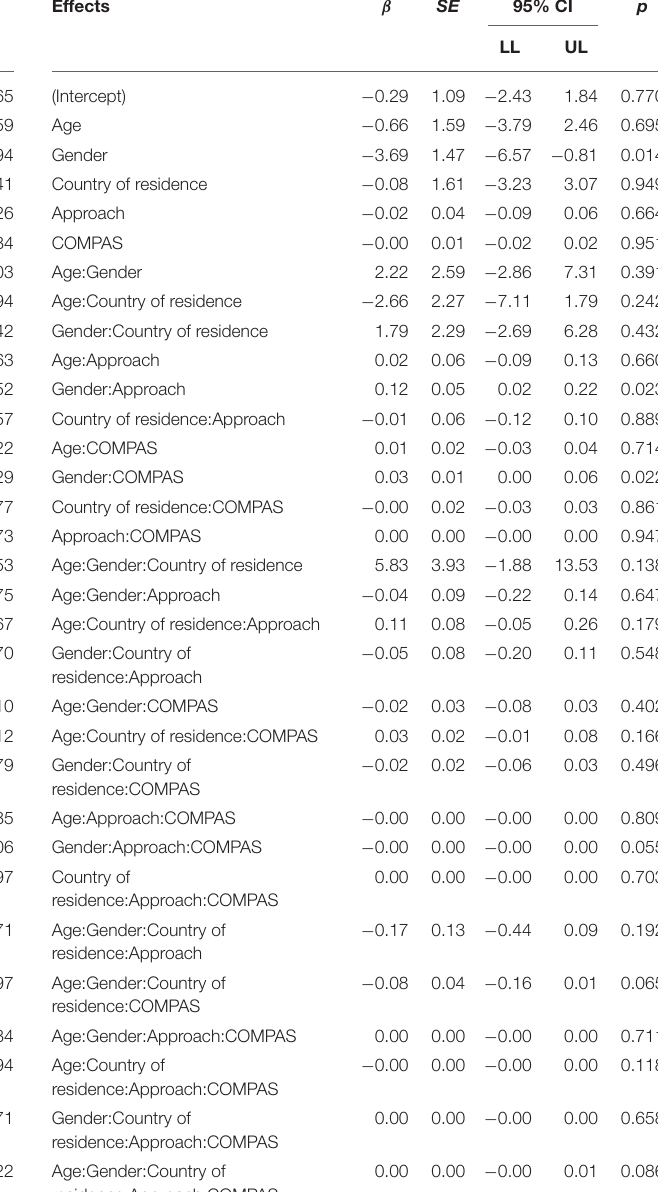
TABLE 3 | Omnibus regression analysis with approach coping.